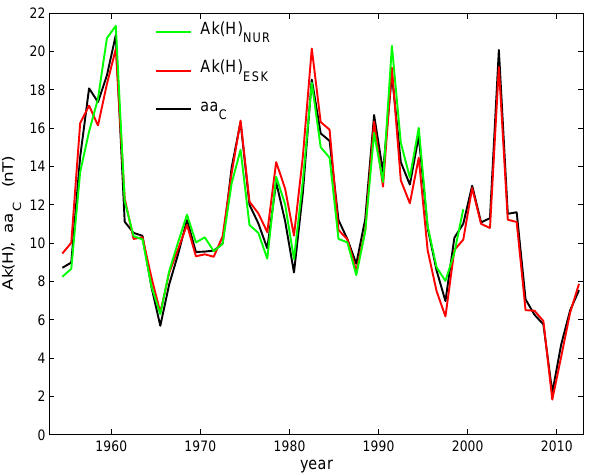
Fig. 5. The variations of the Ak ( H) indices derived from the hor- izontal field observed at Nurmijarvi, Ak ( H) NUR (green, available until 2001), and Eskdalemuir Ak ( H) ESK (red) and the linearly re- gressed corrected aa index, aa C (black).